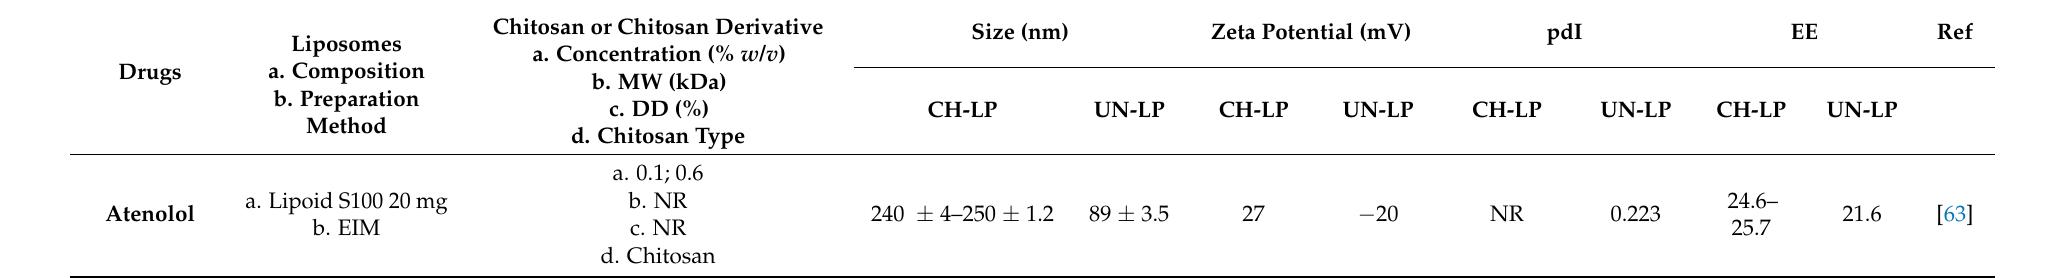
Table 4. Comparison of size, surface charge, homogeneity and drug EE between liposomes and chitosomes loading drugs of different classes. The liposomal composition is indicated in the table in molar ratio except when * exists, indicating a weight ratio ( w/w